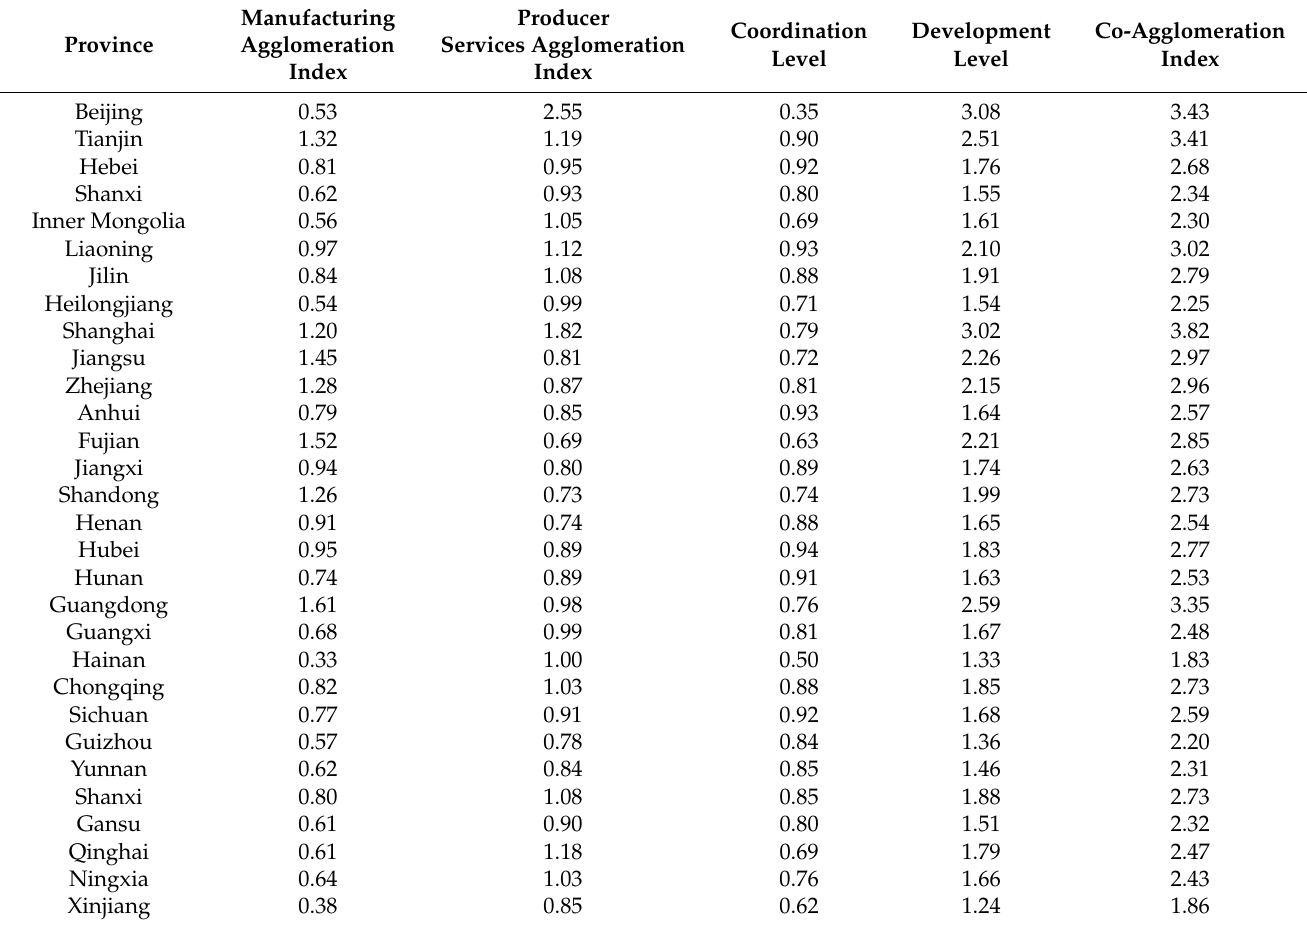
Table 1. Analysis of the co-agglomeration index of manufacturing and producer